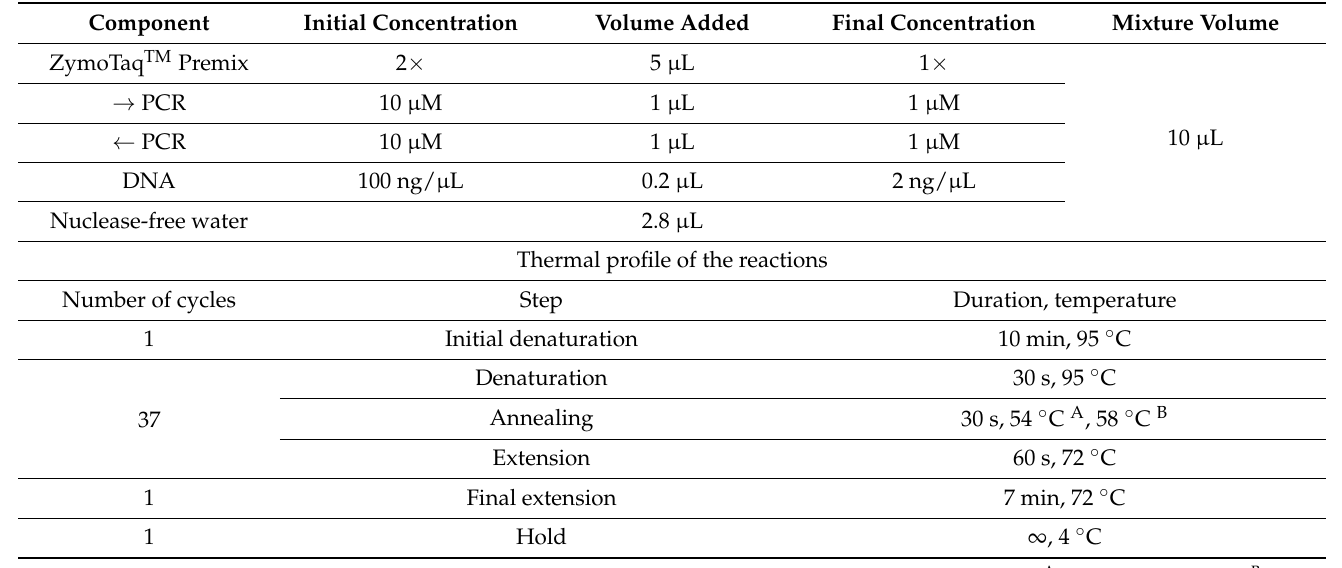
Table 2. PCR mixture content and thermal profile of the reactions (data adapted from previously published paper